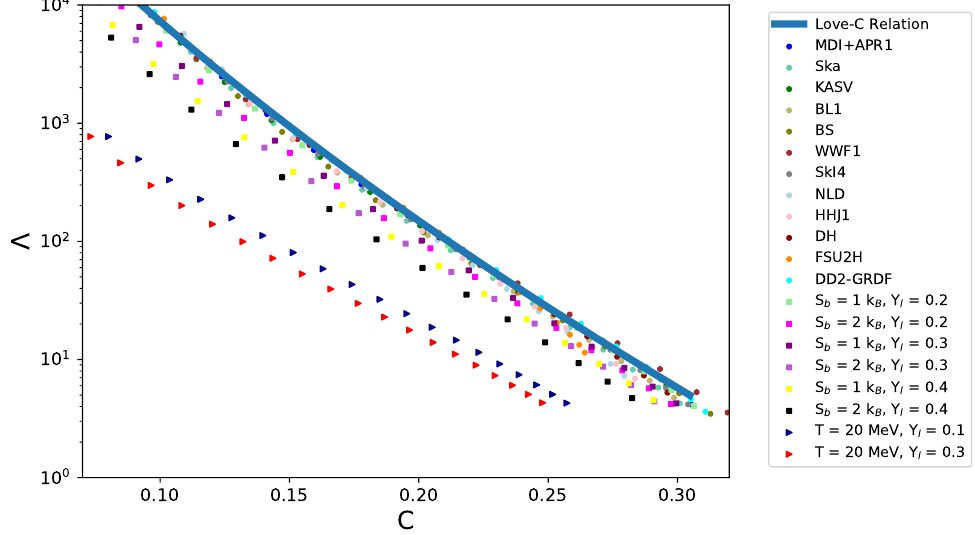
Figure 4. Universal relation connecting the tidal deformability and the star’s compactness. The circular points correspond to cold EOS, whereas the rectangular and the triangular points stand for isentropic and isothermal neutron stars, respectively. The blue solid line corresponds to the